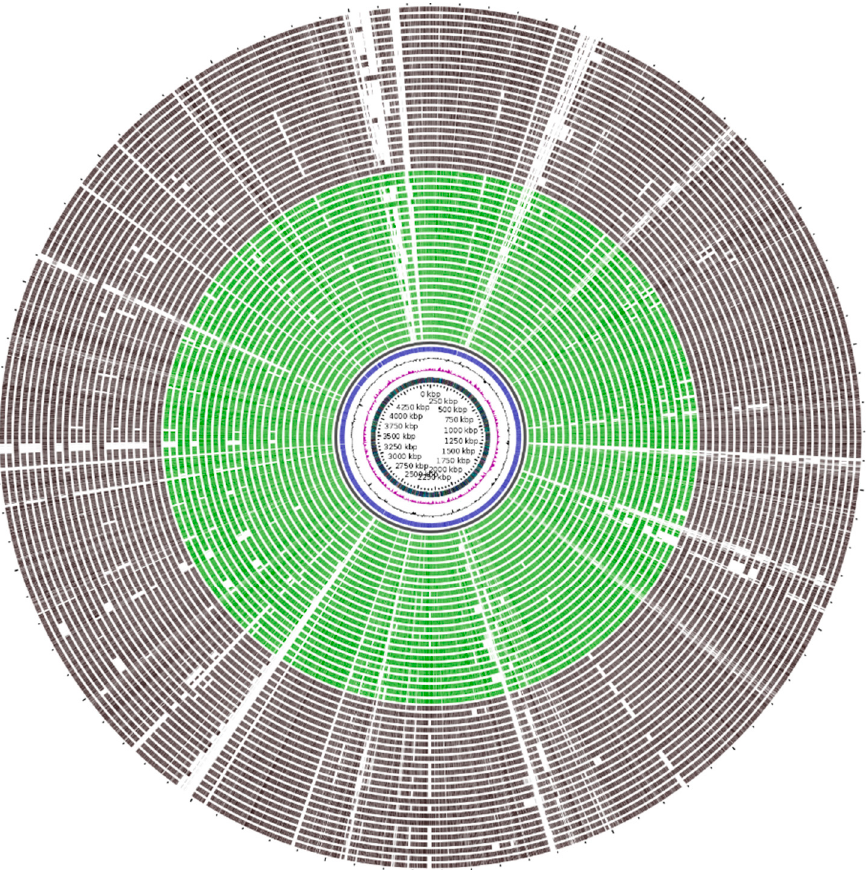
Figure 5. Blast atlas (A—circular) showing sequences similarity and diversity among true ESBL and presumptive non-ESBL E. coli using E. coli MG1655 as a reference: Isolates shown in this analysis are all cattle-derived (cattle feces, catch basins, surface water, and processing plant) and do not include any human-derived presumptive ESBL-EC because WGS did not identify any non-ESBL-EC from humans or municipal sewage sources based on the presence of bla SHV , bla TEM , bla OXA , or bla CTX-M . Inner ring comprises GC skew, GC content, and sequence of reference E. coli MG1655, while middle and outer rings comprise ESBL and non-ESBL E. coli , respectively.